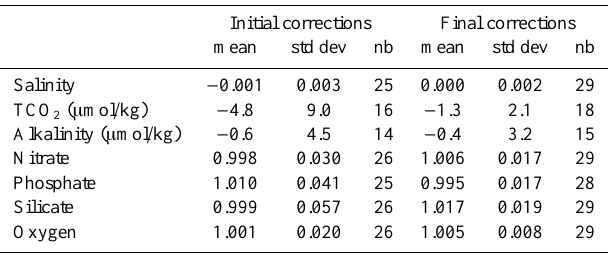
Table 5. Statistics for the Indian sector of the Southern Ocean (same as Table 4 for cruises listed in Table